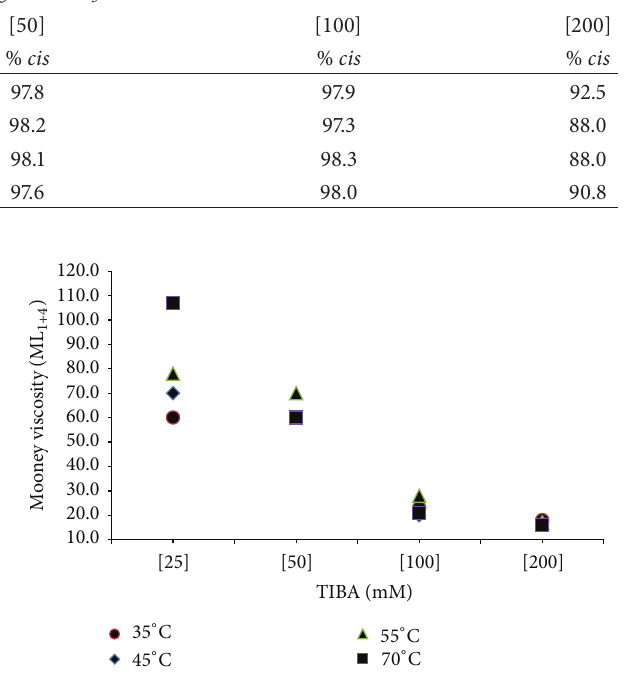
Figure 5: Mooney viscosity versus TIBA of high cis